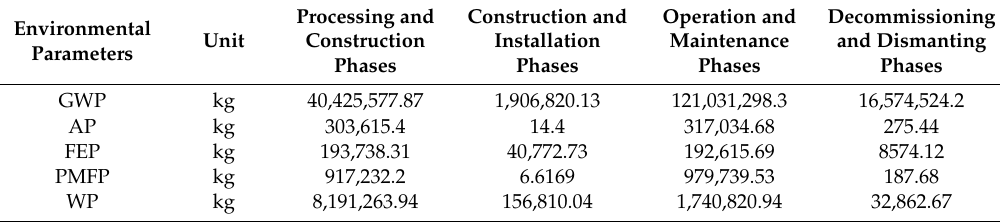
Table 5. List of environmental impact criteria for a cable-stayed bridge at each